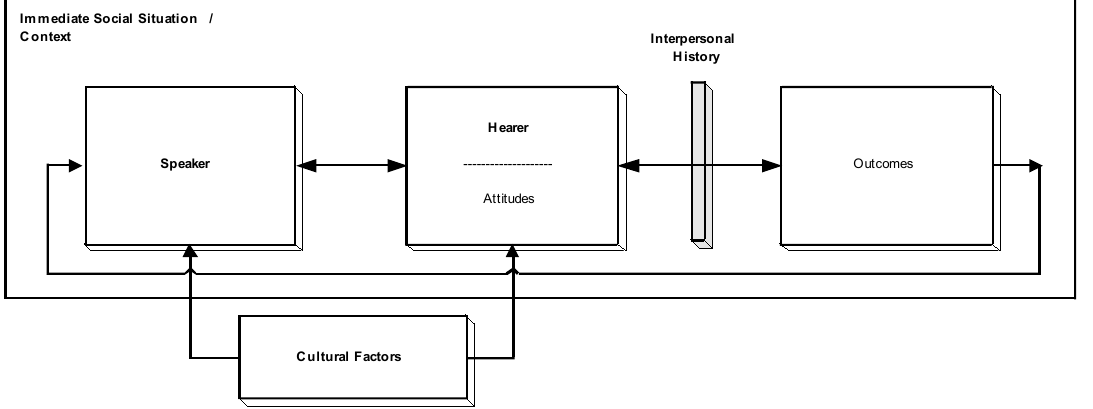
Figure 1. Social Process